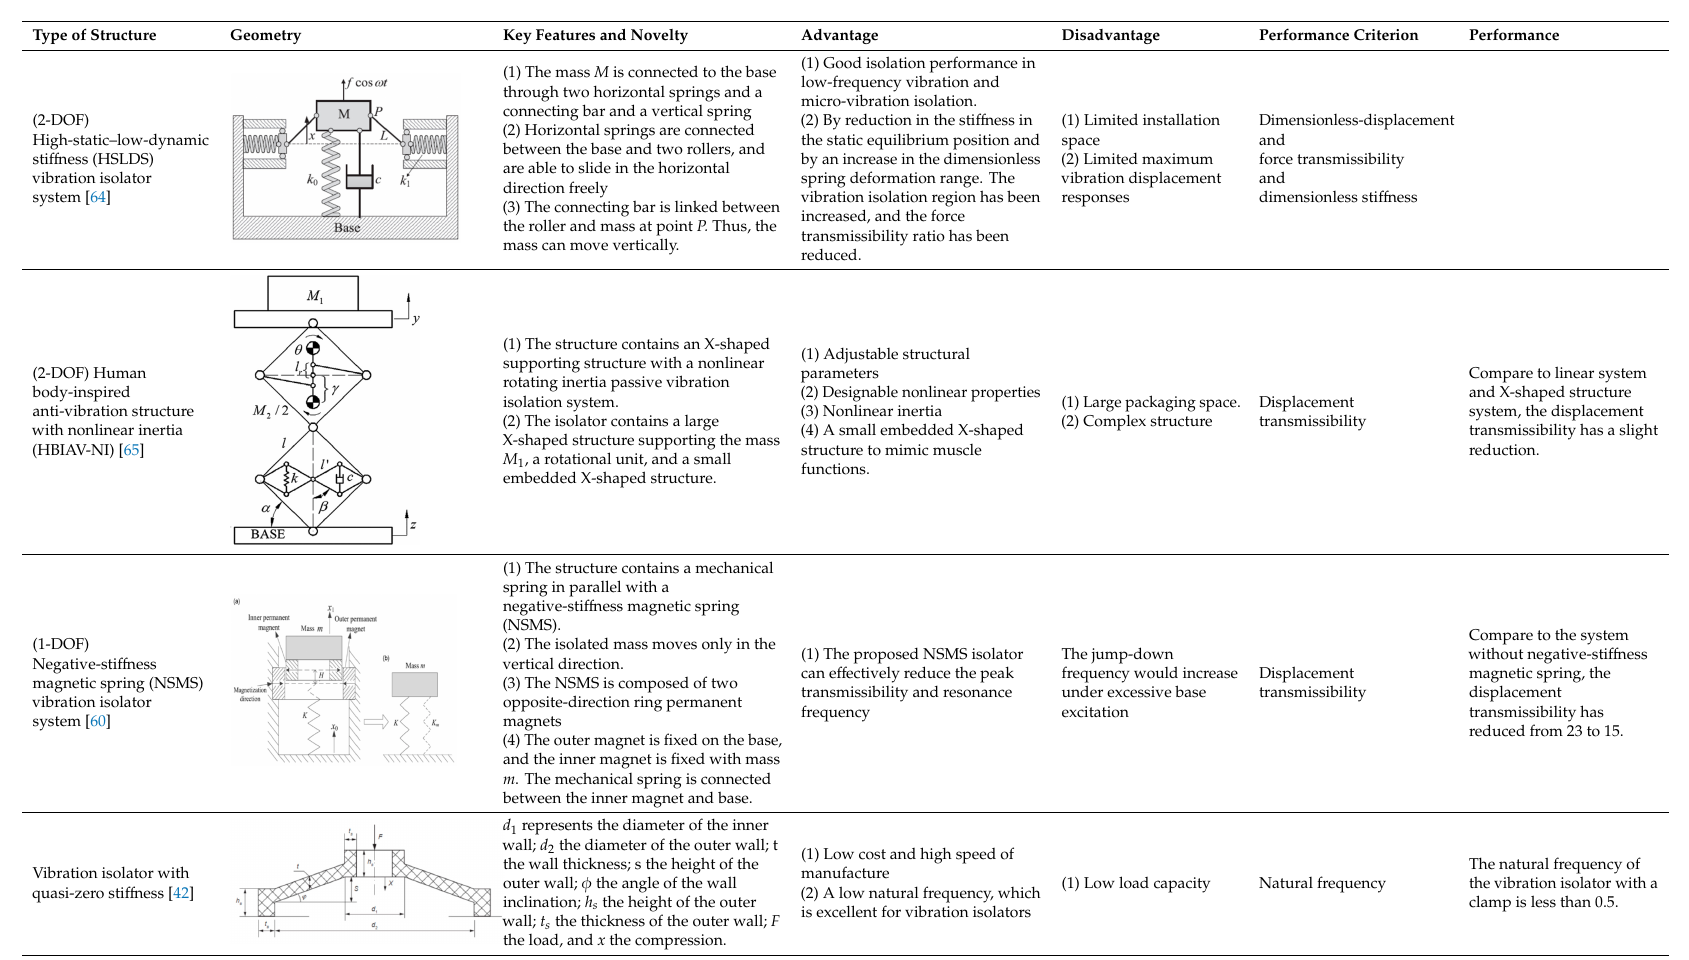
clamp is less than